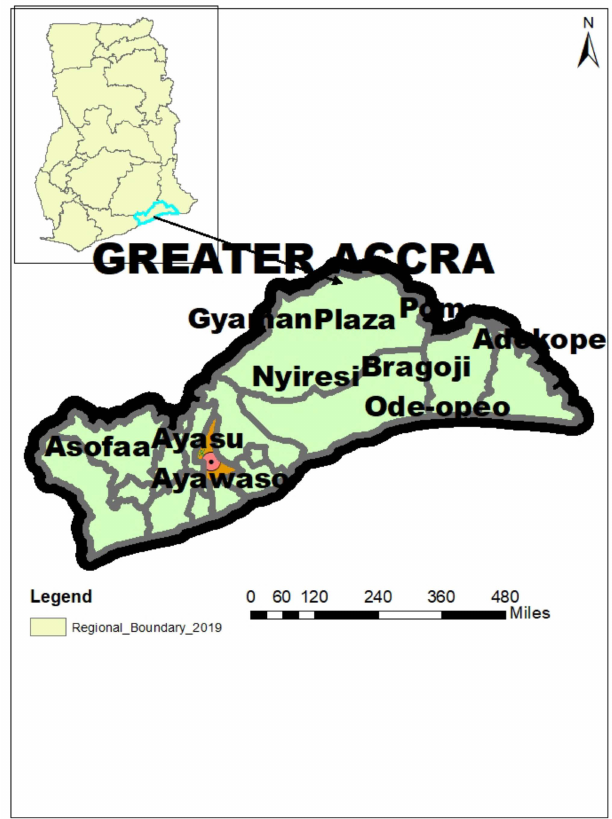
Figure 1. Map of the study area.